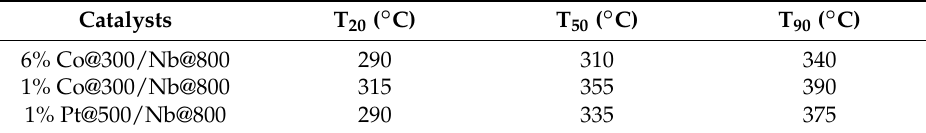
Table 5. T 20 , T 50 , and T 90 of fresh Co catalysts and Pt catalysts for propane oxidation. Figure 7. Fresh cobalt oxide catalyst and fresh platinum catalyst for propane oxidation ( left ); aged cobalt oxide and aged platinum on niobium oxide for propane oxidation ( right ). Impregnated platinum catalysts were calcined at 500°C. Aging was conducted at 400 °C with reaction gases for 12 h. C 3 H 8 0.1 vol %, O 2 18.9 vol %, N 2 81 vol %. Catalysis volume: 0.1 mL; GHSV: 64,800 (h − 1 ). Table 6. T 20 , T 50 , and T 90 of aged Co catalysts and Pt catalysts for propane oxidation.